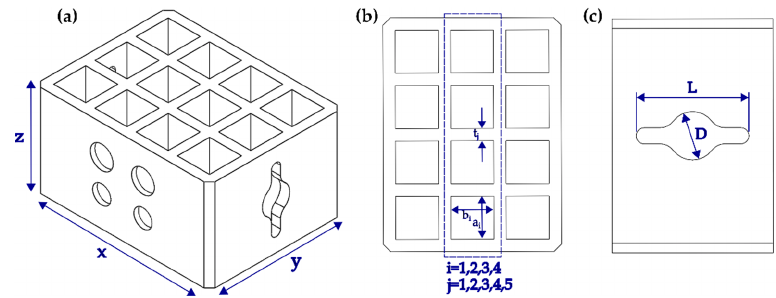
Figure 3. Probes for geometrical characterization: ( a ) overall dimensions; ( b ) top surface; and ( c ) lateral surface details.